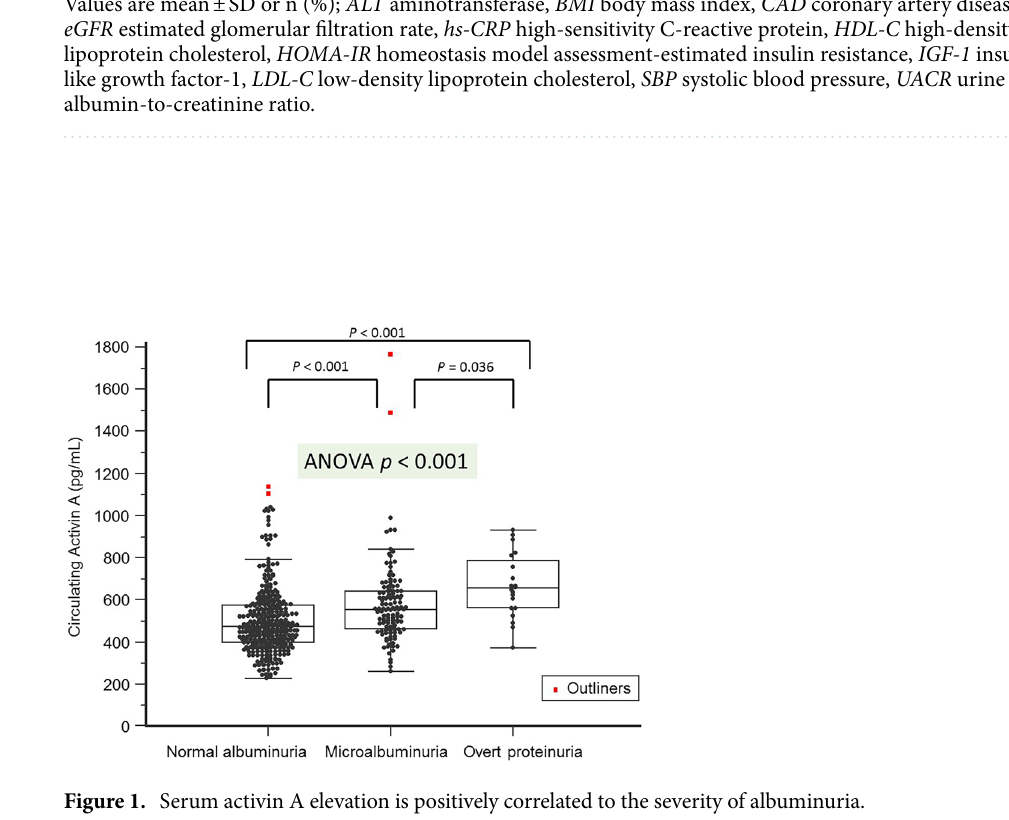
Table 1. Comparison of general characteristics among the different albuminuria status. * p < 0.05, ** p < 0.001. Values are mean ± SD or n (%); ALT aminotransferase, BMI body mass index, CAD coronary artery disease,